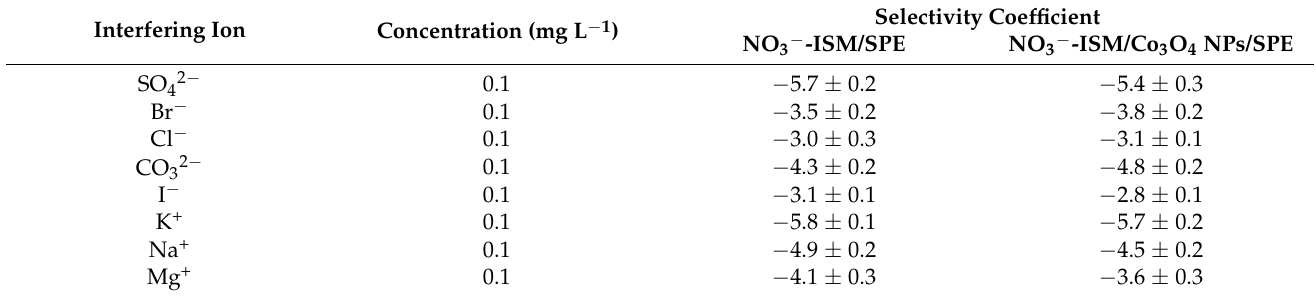
Table 1. Selectivities of the NO 3 − -ISM/SPE and NO 3 − -ISM/Co 3 O 4 NPs/SPE.